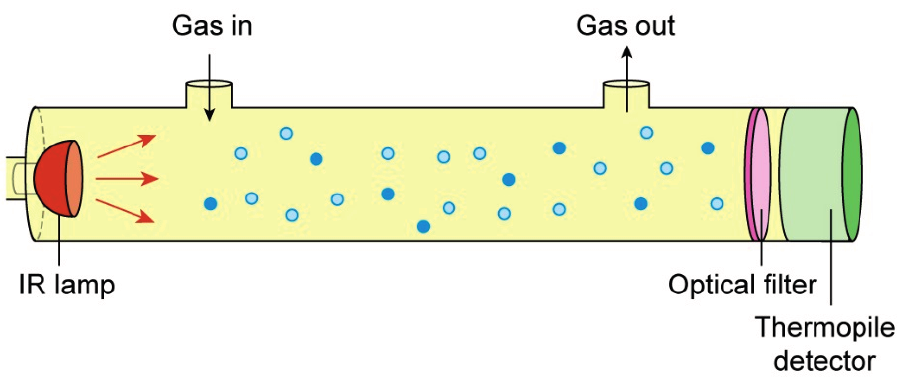
Figure 1. Sketch of the Non Dispersive Infra-Red (NDIR) carbon dioxide (CO 2 ) sensor structure. The NDIR sensors were connected to a datalogger system (CR1000, Campbell Scientific,